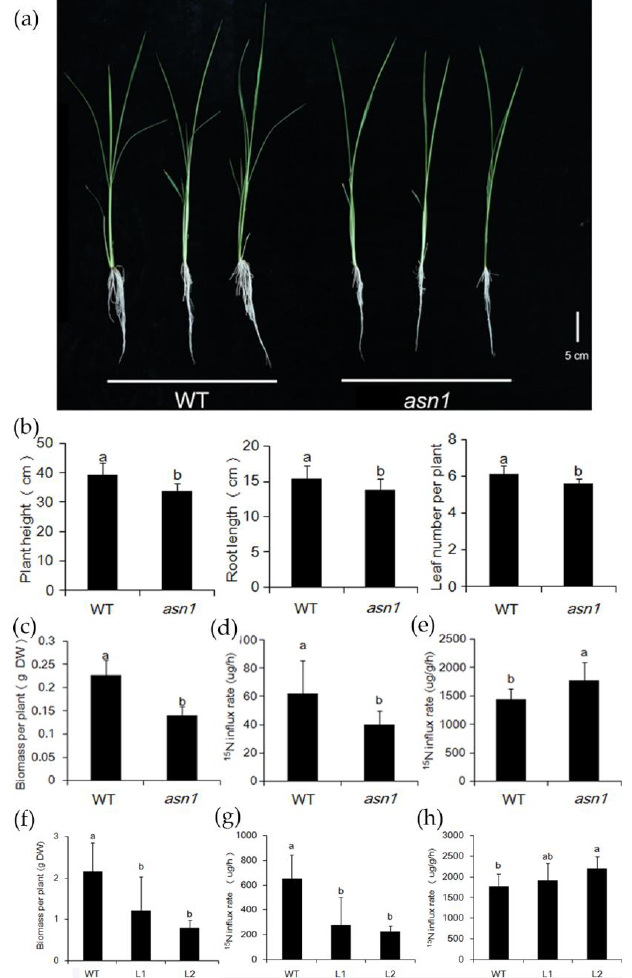
Figure 7. 15 N-NH 4+ influx rate of WT and asn1 . ( a ) WT and asn1 were cultured for 20 days; ( b ) plant height, root length, and leaf number of WT and asn1 ; ( c ) biomass of WT and asn1 ; DW, dry weight; ( d ) 15 N influx rate of WT and asn1 per plant; ( e ) 15 N influx rate of WT and asn1 per unit root weight. Data are mean ± SD ( n ≥ 9). Means with different letters are significantly different; ( f ) biomass of WT and L1, L2; ( g ) 15 N influx rate of WT and L1, L2 per plant; ( h ) 15 N influx rate of WT and L1, L2 per unit root weight. Data are mean ± SD ( n ≥ 4). Means with different letters are significantly different.